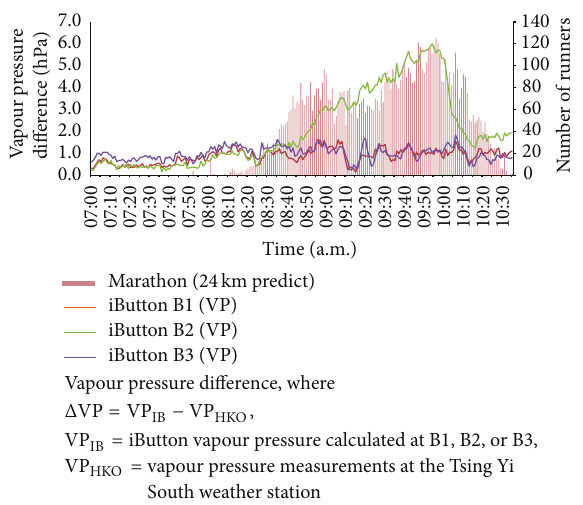
Figure 7: Minute-by-minute vapour pressure difference and runner counts at the Cheung Tsing Tunnel (Site B: semienclosed